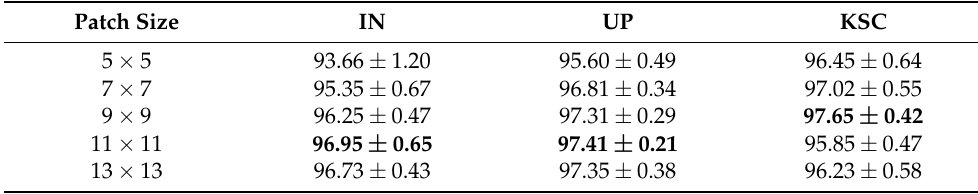
Table 2. Classification performance of all three data sets with the input patch size of the LMFN ranging from 5 × 5 to 13 × 13, in terms of OA (%). The best results are highlighted in bold font. Patch Size IN UP KSC 5 × 5 93.66 ± 1.20 95.60 ± 0.49 96.45 ± 0.64 7 × 7 95.35 ± 0.67 96.81 ± 0.34 97.02 ± 0.55 9 × 9 96.25 ± 0.47 97.31 ± 0.29 97.65 ± 0.42 11 × 11 96.95 ± 0.65 97.41 ± 0.21 95.85 ± 0.47